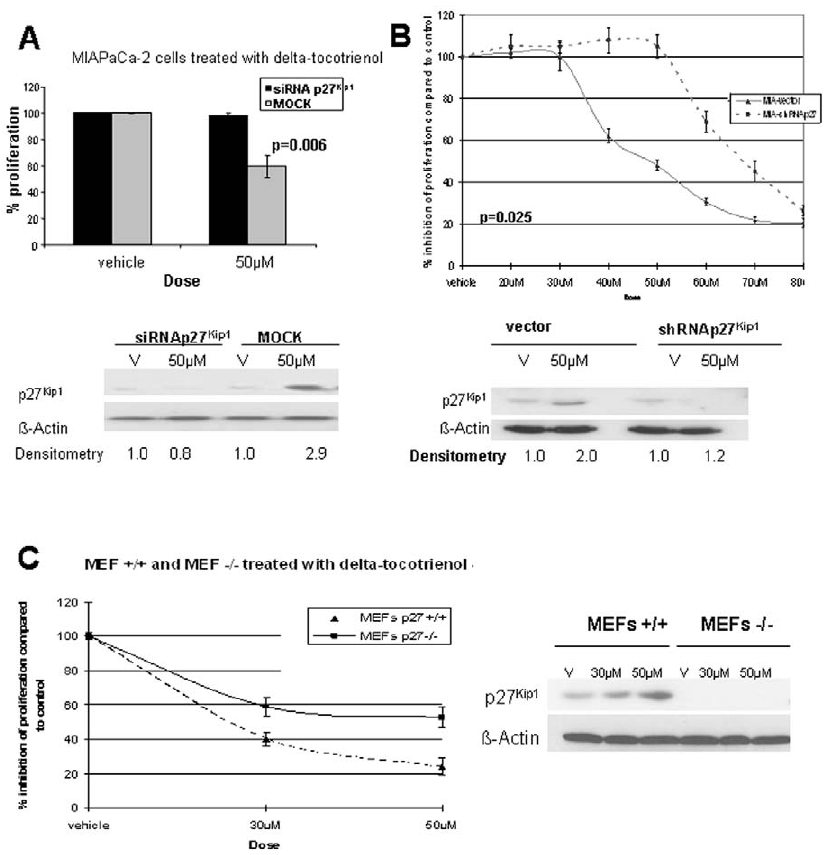
Figure 3. p27 Kip1 is required for d -tocotrienol-induced G 1 arrest. A, p27 Kip1 siRNA attenuates d -tocotrienol-mediated growth suppression in human MIAPaCa-2 pancreatic cancer cells. After transfection with p27 Kip1 siRNA or with noncoding siRNA for 24 hours, MIAPaCa-2 cells were incubated with fresh medium containing either d -tocotrienol (IC 50 ) or vehicle for an additional 24 hours. Cells were taken from culture and divided into 2 aliquots. Immunoblots demonstrate inhibited p27 Kip1 expression with siRNA p27 Kip1 and rescue from inhibition of proliferation in siRNA p27 Kip1 -pretreated cells. B, MIAPaCa-2 cells expressing stable shRNA p27 Kip1 are protected from the growth inhibitory effects of d -tocotrienol. Stable MIAPaCa-2 cells expressing shRNAp27 Kip1 or empty vector were treated with increasing concentrations of d -tocotrienol or vehicle for 24 hours, with proliferation determined by MTT assay. MIAPaCa-2 cells expressing shRNAp27 Kip1 demonstrate resistance to growth inhibitory effects of d -tocotrienol. C, p27 Kip1 knockout cells attenuate d -tocotrienol-mediated growth inhibitory effects. Stable MEF p27 Kip1 ( 2 / 2 ) and MEF p27 Kip1 ( + / + ) were plated and incubated with either d -tocotrienol at the indicated doses or with vehicle for 48 hours. Cell cultures were then collected in 2 aliquots and analyzed as reported previously for siRNA p27 Kip1 -treated cells. In the absence of p27 Kip1 expression, d -tocotrienol exerts minimal growth inhibitory effects in mouse epithelial cells.